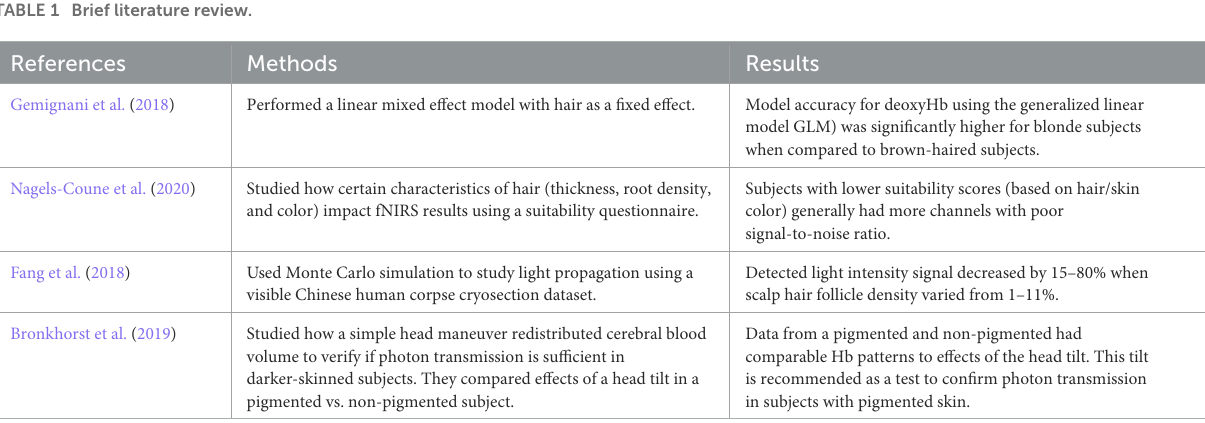
TABLE 1 Brief literature